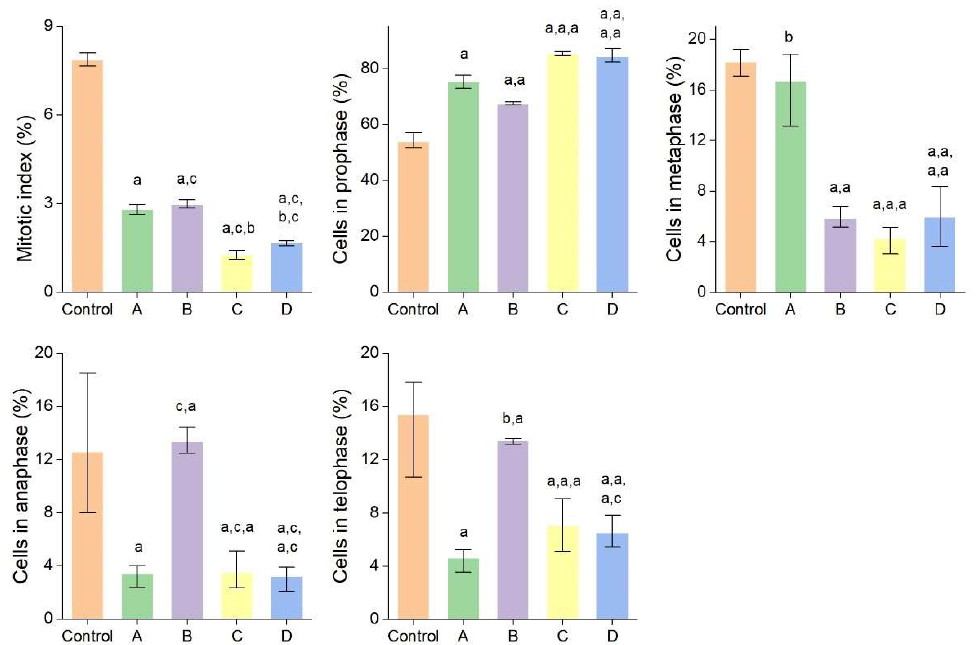
Figure 8. Mitotic index values and percentages of cells in mitosis stages in Allium cepa root meristems exposed to Picea abies bark extract ( A ), Pinus nigra bark extract ( B ), Picea abies bark extract derived AgNPs ( C ) and Pinus nigra bark extract derived AgNPs ( D ); a : p < 0.001; b : p < 0.05; c : no significance.